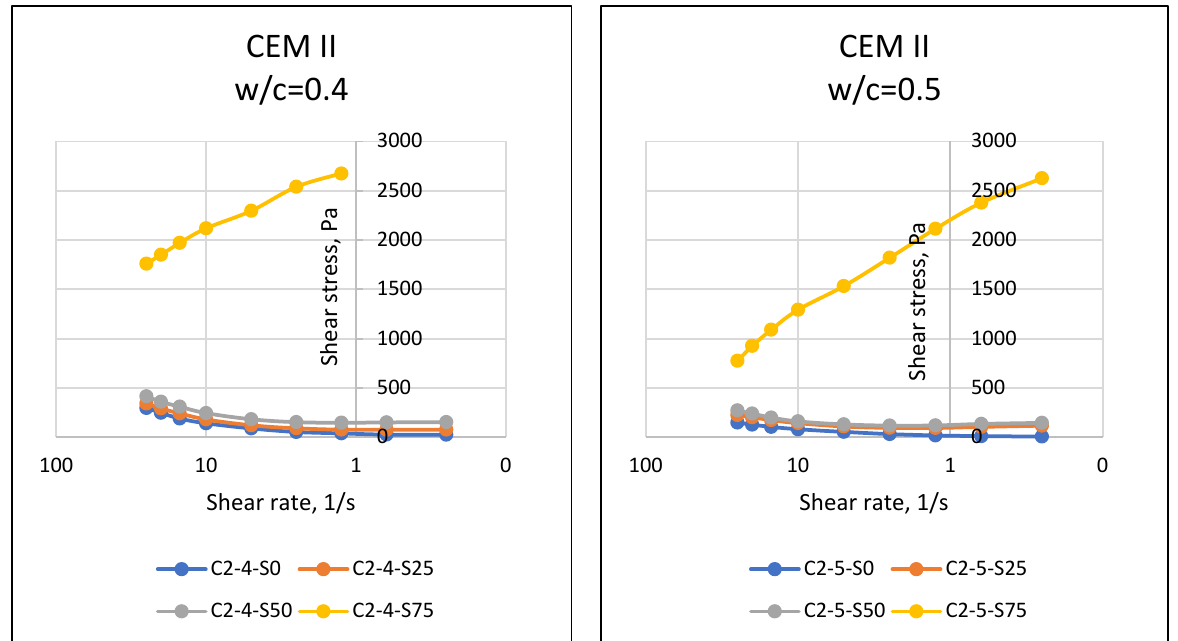
Figure 6. Shear Stress–Shear Rate Relationships of SAPCPs with CEM II (w/c = 0.40 and 0.50).